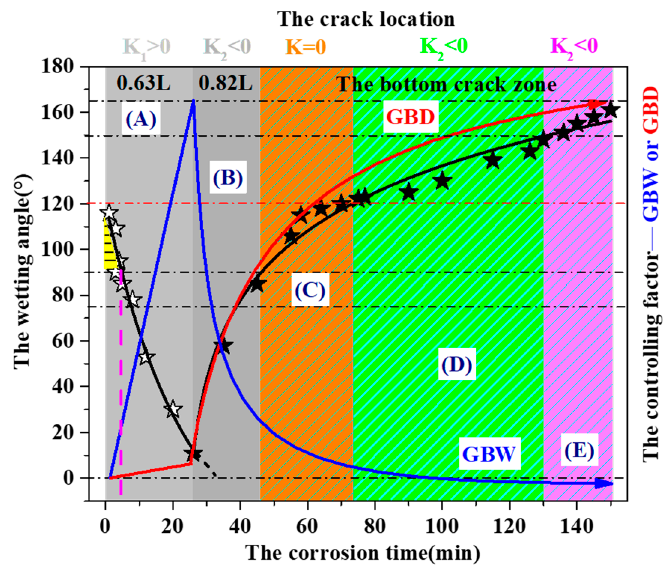
Figure 16. The proposed crack mechanism map with the dependence on GBW and GBD, and the related crack nucleation area, A and B zone are mainly affected by GBW while C, D and E zones mainly rely on GBD. (A: 0.63 L zone, B: 0.82 L zone, C, D and E zones: the bottom crack zone.).